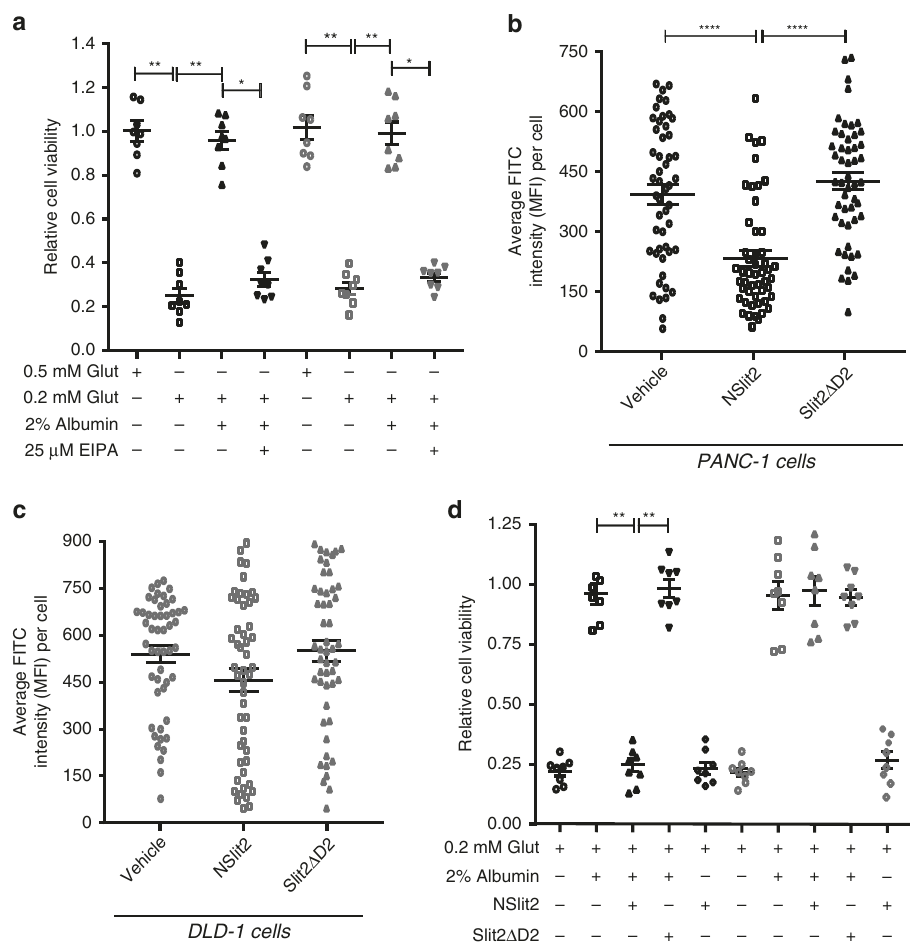
Fig. 6 NSlit2 attenuates protein uptake by macropinocytosis in cancer cells and restricts their growth in a ROBO1-dependent manner. a – d All data are presented as mean ± SEM. Comparisons between the groups were made by Kruskal – Wallis ANOVA, followed by Dunn ’ s multiple comparisons test. PANC- 1 and DLD-1 treatments are represented by black and gray symbols, respectively. a , d n = 8 independent replicates per treatment group per experiment over three independent experiments. a Oncogenic KRAS-expressing PANC-1 and DLD-1 cells were grown for 6 days in glutamine-free medium supplemented with high glutamine (Glut) (0.5 mM), low Glut (0.2 mM), 2% albumin. The macropinocytosis inhibitor, EIPA, was added, where indicated, for the last 2 days. Cell viability was measured on Day-6 using a MTT assay kit. Data are represented relative to the values obtained for 0.5 mM Glut supplementation. ** p = 0.0015 and 0.0012, 0.5 mM vs 0.2 mM Glut for PANC-1 and DLD-1 cells, respectively; ** p = 0.0013 and 0.0036, 0.2 mM Glut vs 0.2 mM Glut + 2% Alb for PANC-1 and DLD-1 cells, respectively; and * p = 0.0276 and 0.0360, 0.2 mM Glut + 2% Albumin vs 0.2 mM Glut + 2% Albumin + 25 µ M EIPA for PANC-1 and DLD-1 cells, respectively. b , c n = 50 cells per treatment group per experiment over three independent experiments. b PANC-1 cells were incubated with vehicle, NSlit2, or Slit2 Δ D2 for 15 min at 37 °C and macropinocytosis assays performed as described in Fig. 4a using Albumin-FITC in place of the TMR-labeled dextran. Mean fl uorescence intensity (MFI) of the FITC channel per cell was measured using ImageJ software, version 1.51 v. **** p < 0.0001, NSlit2 vs vehicle, or Slit2 Δ D2. c Experiments were performed as in ( b ) using DLD-1 cells instead of PANC-1 cells. p = 0.4469 and 0.2049, NSlit2 vs vehicle or Slit2 Δ D2, respectively. ( d ) Cell viability assays were performed as described in ( a ) with addition of 0.2 mM glutamine, 2% albumin, NSlit2 and Slit2 Δ D2 to the medium for 6 days, as indicated. ** p = 0.0061 and >0.9999, 0.2 mM Glut + 2% Albumin vs 0.2 mM Glut + 2% albumin + NSlit2 for PANC-1 and DLD-1 cells, respectively. ** p = 0.0048 and >0.9999, 0.2 mM Glut + 2% Albumin + NSlit2 vs 0.2 mM Glut + 2% Albumin + Slit2 Δ D2 for PANC-1 and DLD-1 cells, respectively. Source data for ( a – d ) are provided as a Source Data fi